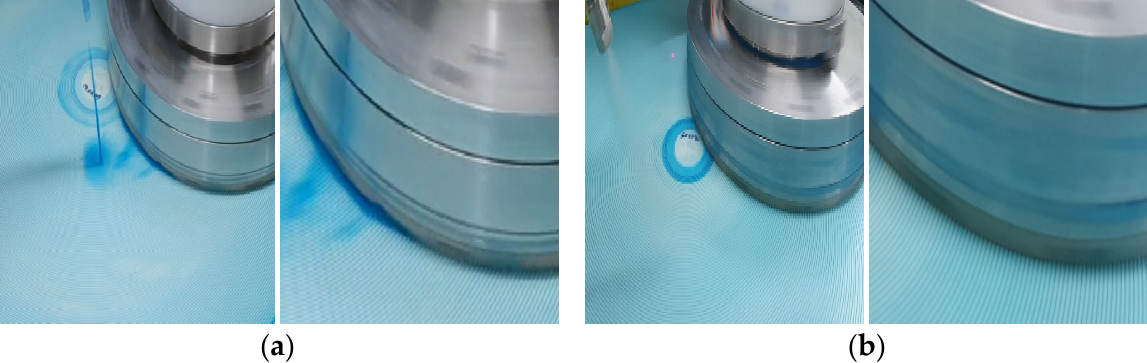
Figure 1. Comparison of the slurry supply on the pad and the bow wave using dyed slurry. Images of ( a ) the conventional slurry supply system and ( b ) the hybrid slurry supply system.